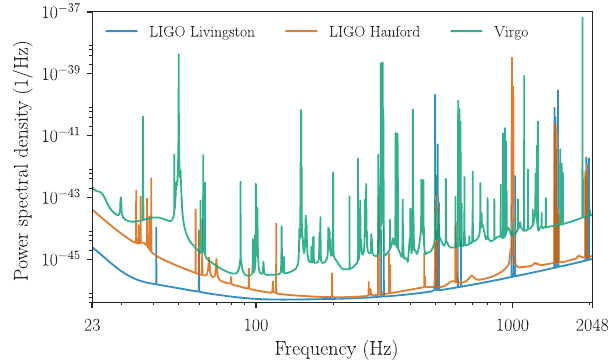
FIG. 1. PSDs of the Advanced LIGO – Advanced Virgo net- work. Shown, for each detector, is the median PSD computed from a posterior distribution of PSDs as estimated by B AYES- W AVE [39,47] using 128 s of data containing the signal GW170817.